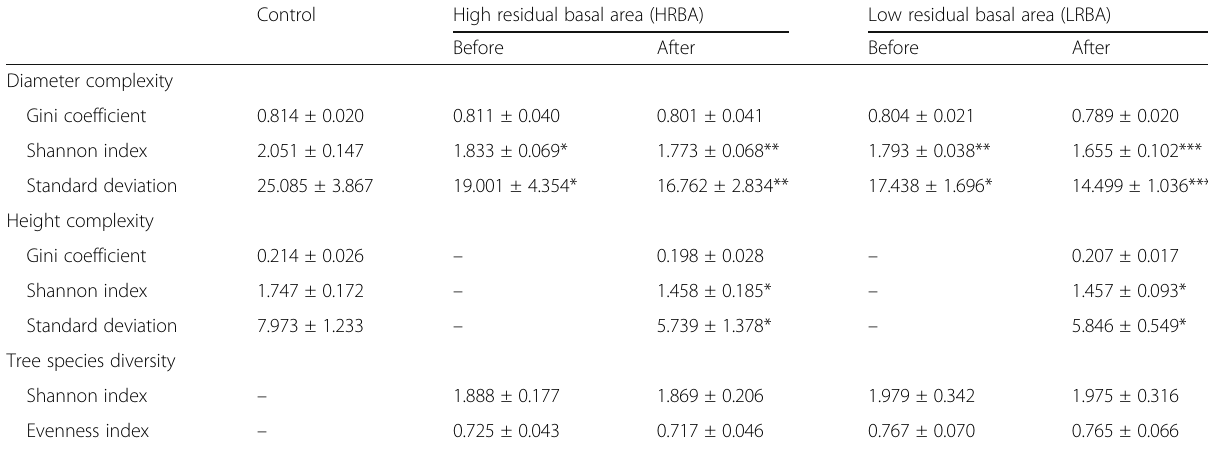
Table 3 Mean values for the Gini coefficient, the Shannon index and the standard deviation for diameter at breast height (dbh) and height data and for the Shannon index and the evenness index for species diversity before and after harvesting. Values are expressed as mean ± 1 standard deviation. Significant treatment differences with the control are shown with asterisks after